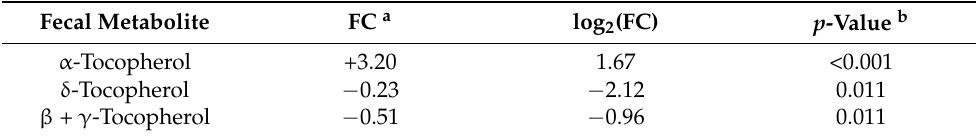
* Treatments were two plots differing in basal concentrations of vitamin E and Se (high: 200 IU/kg vit. E and 1.2 mg/kg Se; low: 20 IU/kg vit. E and 0.3 mg/kg Se). a FC, fold change in the metabolite concentration (H-ESe/L-ESe). b p -value, independent t -test for H-ESe versus L-ESe cows ( P FDR <